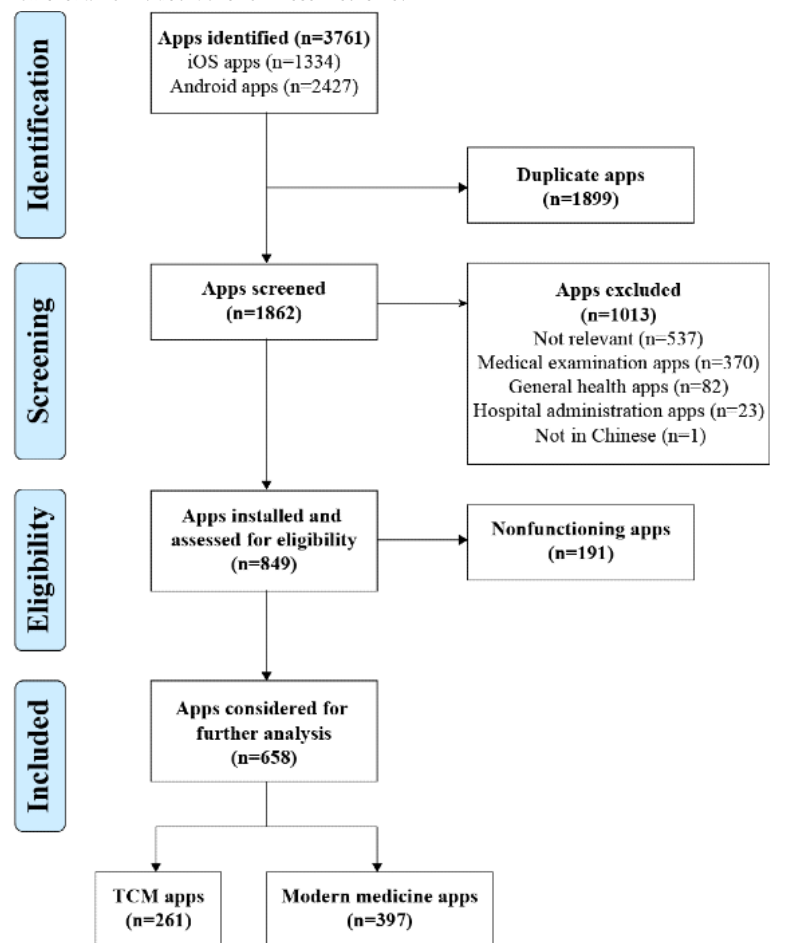
Figure 1. Screening process flowchart. TCM: traditional Chinese